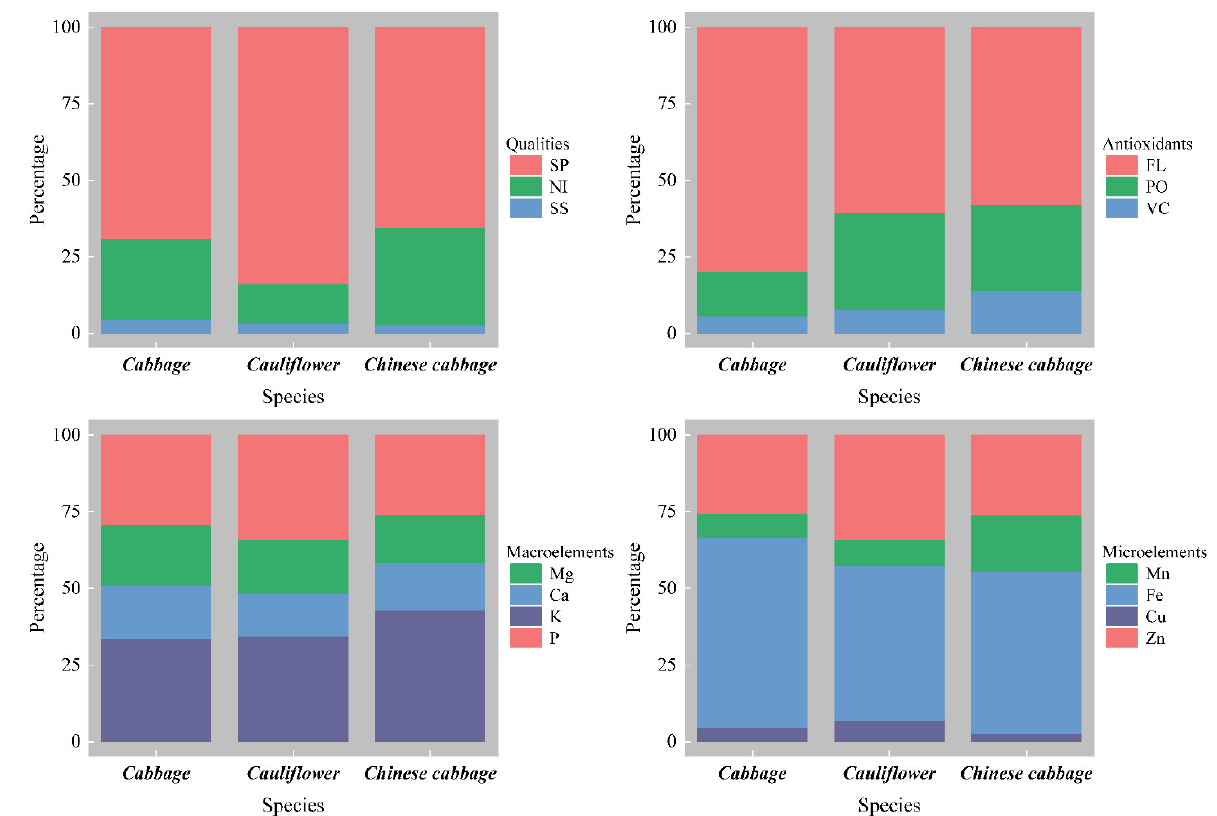
Figure 1. Stacked bar plots showing relative abundances (%) of different quality, antioxidant, and mineral compounds over the total amount of each category present in each of the three species evaluated (cabbage, cauliflower, and Chinese cabbage). The definition for each trait abbreviation can be found in Table 3.